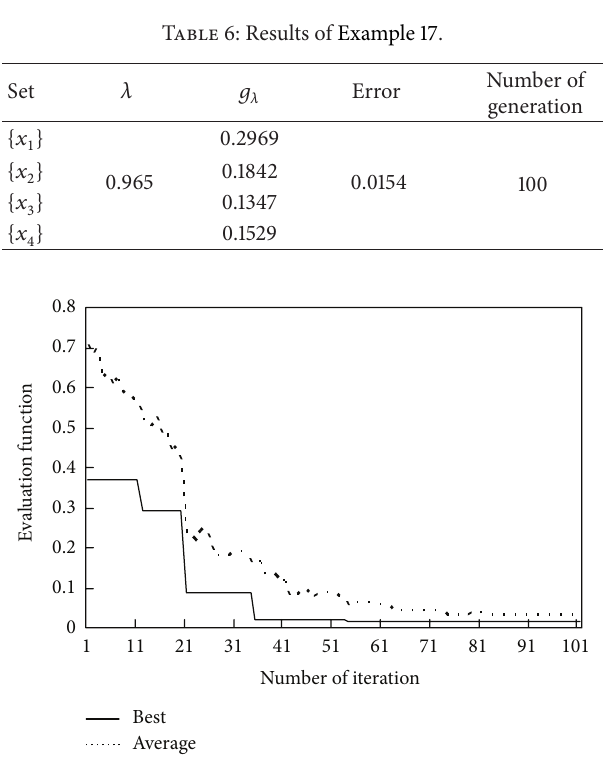
Figure 1: The convergence rate of Example 17.